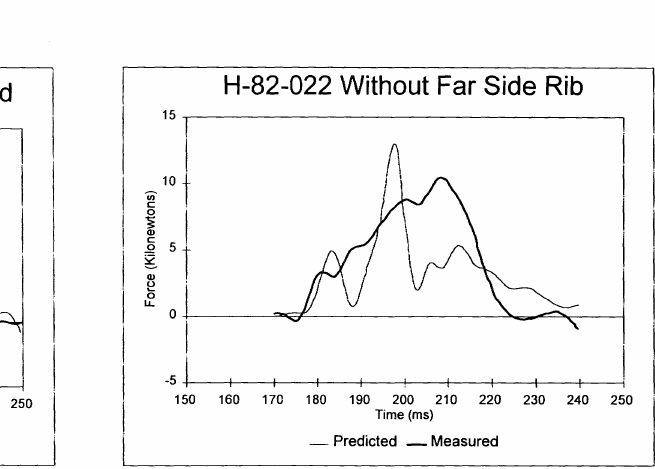
FIGURE 3 Measured and predicted forces using only struck side rib and